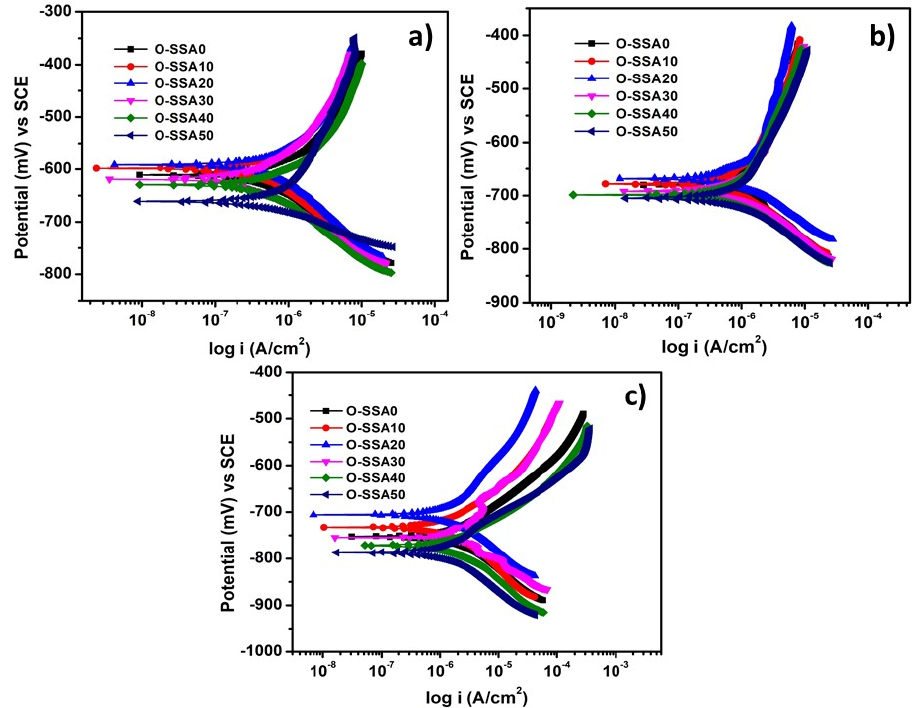
Figure 7. Potentiodynamic polarization curves for steel rebars in various cement extracts for an exposure period of 1 day ( a ); 15 days ( b ); and 30 days ( c ).